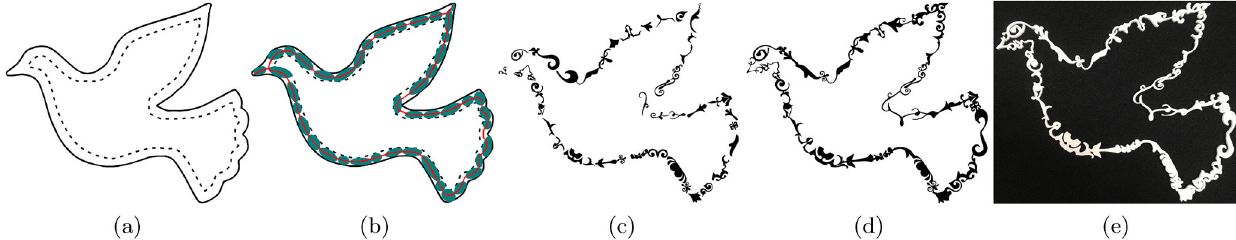
Fig. 2 Given a curve boundary, we generate an inner boundary to build the packing space (a) and compute an ellipse packing in the pipe-like shape guided by the medial axis (b). Then we fit each ellipse with the best matching pattern unit to form the initial collage (c). The user can interactively tune the placements, which is followed by local optimization of the distribution and connectivity enforcement (d). The final result can be 3D printed after simple extrusion